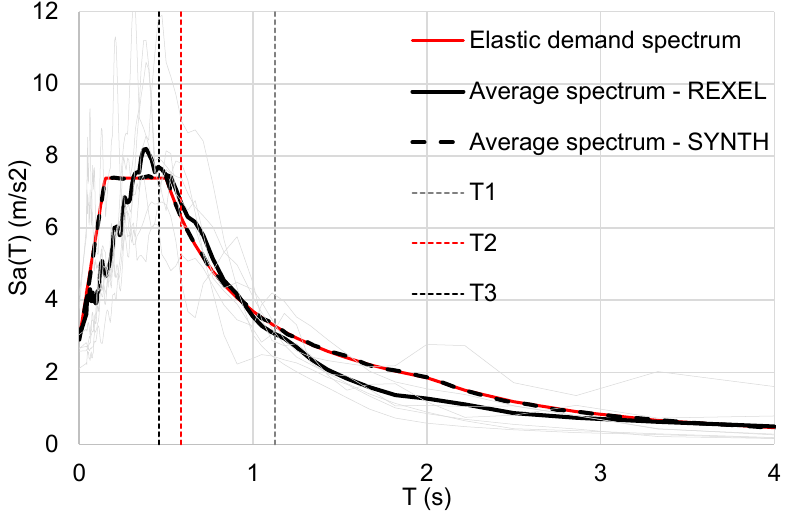
Figure 16. Elastic demand spectrum and average spectrum according to REXEL and SYNTH (T R = 475 yrs).